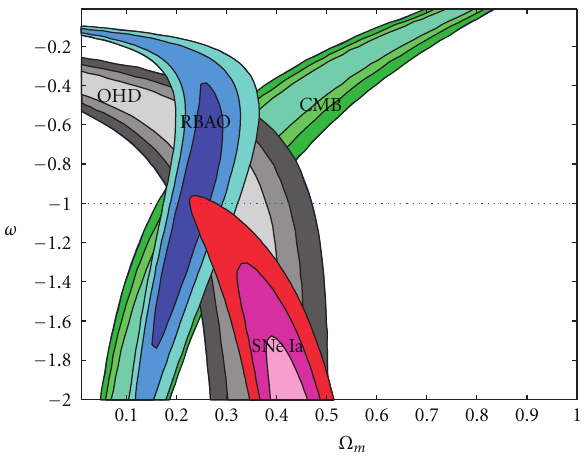
Figure 6: Possible tension between H ( z ) and type Ia supernovae data depicted in the χ 2 fitting results for the spatially flat XCDM model (similar to Λ CDM, except that the dark energy equation of state parameter ω is set free instead of being fixed at ω = − 1). The SN data favor a phantom dark energy with ω < − 1 while other data, including observational H ( z ) (OHD), are consistent with Λ CDM. The OHD used in this figure were the measurements by [28] using the di ff erential age method, and the SN data were from [93]. The RBAO contours were found using the Δ z BAO data in [64]. Confidence regions are 68 . 3%, 95 . 4%, and 99 . 7%, respectively. This figure first appeared in [91, Figure